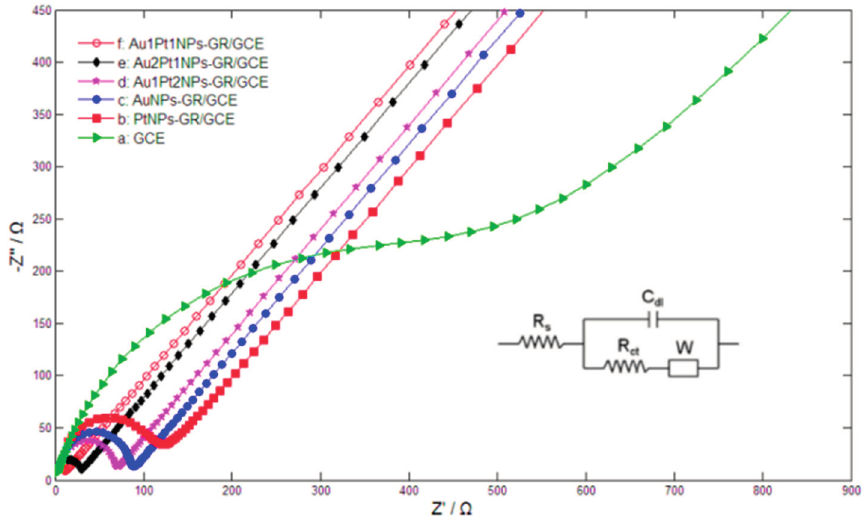
Figure 3. Nyquist plots of bare GCE ( a ); PtNPs-GR/GCE ( b ); AuNPs-GR/GCE ( c ); Au1Pt2NPs-GR/GCE ( d ); Au2Pt1NPs-GR/GCE ( e ) and Au1Pt1NPs-GR ( f ) in 2 mM [Fe(CN) 6 ] 3 − /4 − + 0.1 M KCl solution with the frequencies swept from 10 6 to 0.01 Hz and the AC voltage amplitude of 5 mV. Inset figure is the Randles circuit